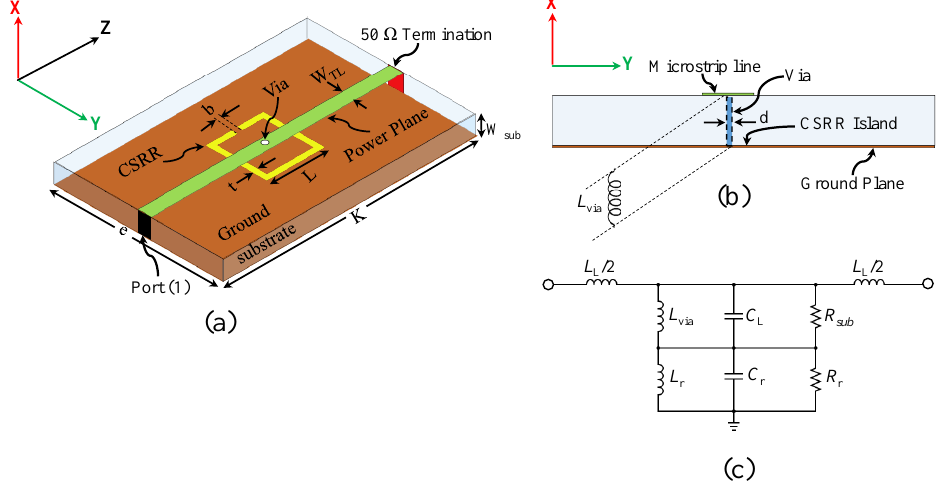
Figure 3. ( a ) The schematic of the proposed CSRR excited using one-port microstrip line